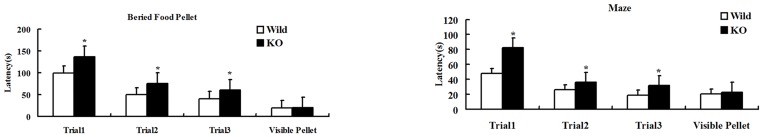
Impaired olfaction in Lgl1 mutant mice revealed by behavioral testing.Olfactory performance was tested in buried food pellet and olfactory maze tests as described above. A) Buried food pellet test. The latency for mice to recover a buried food pellet was recorded on each of 3 consecutive testing days (means±se, *P<0.05, paired t test n = 9 mice/group). Latency times are not significantly different in a control visible pellet test (P = 0.16). B) Olfactory maze test. The latency for mice to recover a hidden food pellet was recorded (means±se, *P<0.05, paired t test, n = 9 mice/group;). Latency times are not significantly different in the control visible pellet test (P = 0.14).